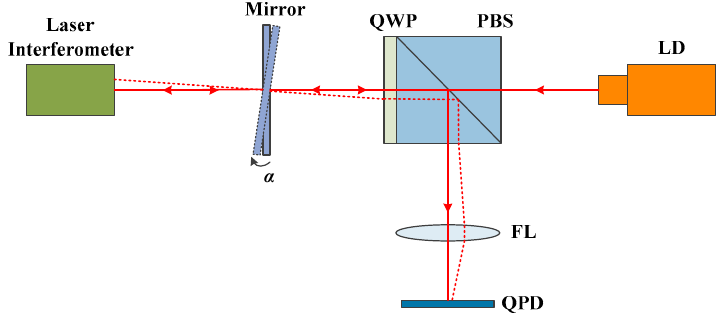
Figure 6. Schematic of the calibration setup.